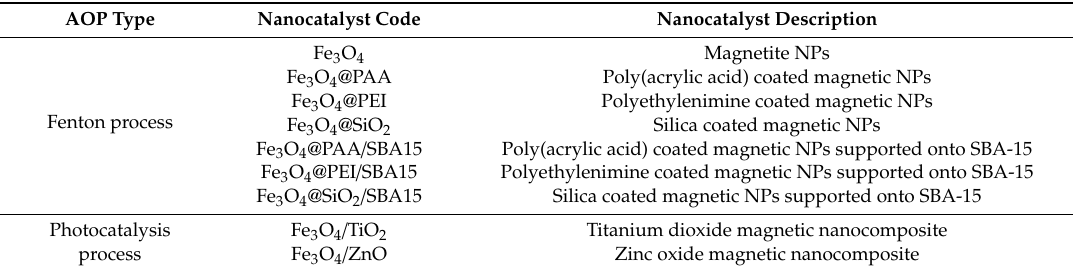
Table 3. Selected nanoparticles used in di ff erent AOPs